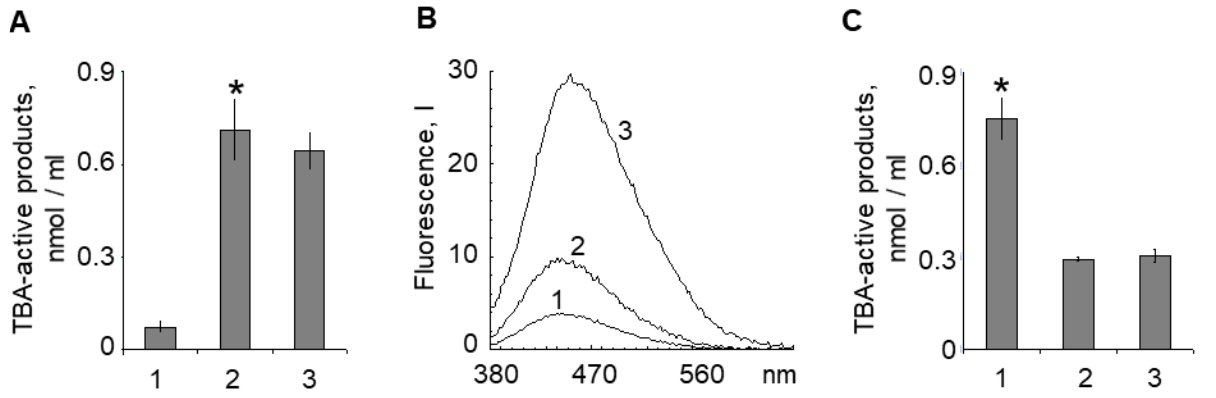
Figure 6. ( A ) Concentrations of thiobarbituric acid (TBA)-active products in samples of the super- natants from the original lipofuscin granule (LG) suspension (1), LG suspension irradiated with visible light for 60 min (2), or LG suspension oxidized by superoxide radicals (3). ( B ) Fluorescence spectra of the supernatants (the spectrum numbers correspond to the sample numbers in panel A ). The fluorescence excitation wavelength was 365 nm. ( C ) Supernatant content of TBA-active products from LG suspension irradiated with visible light for 90 min (1), and in the aqueous (2) and chloroform (3) fractions. Data are presented as means ± SD from three independent experiments. * p < 0.05.